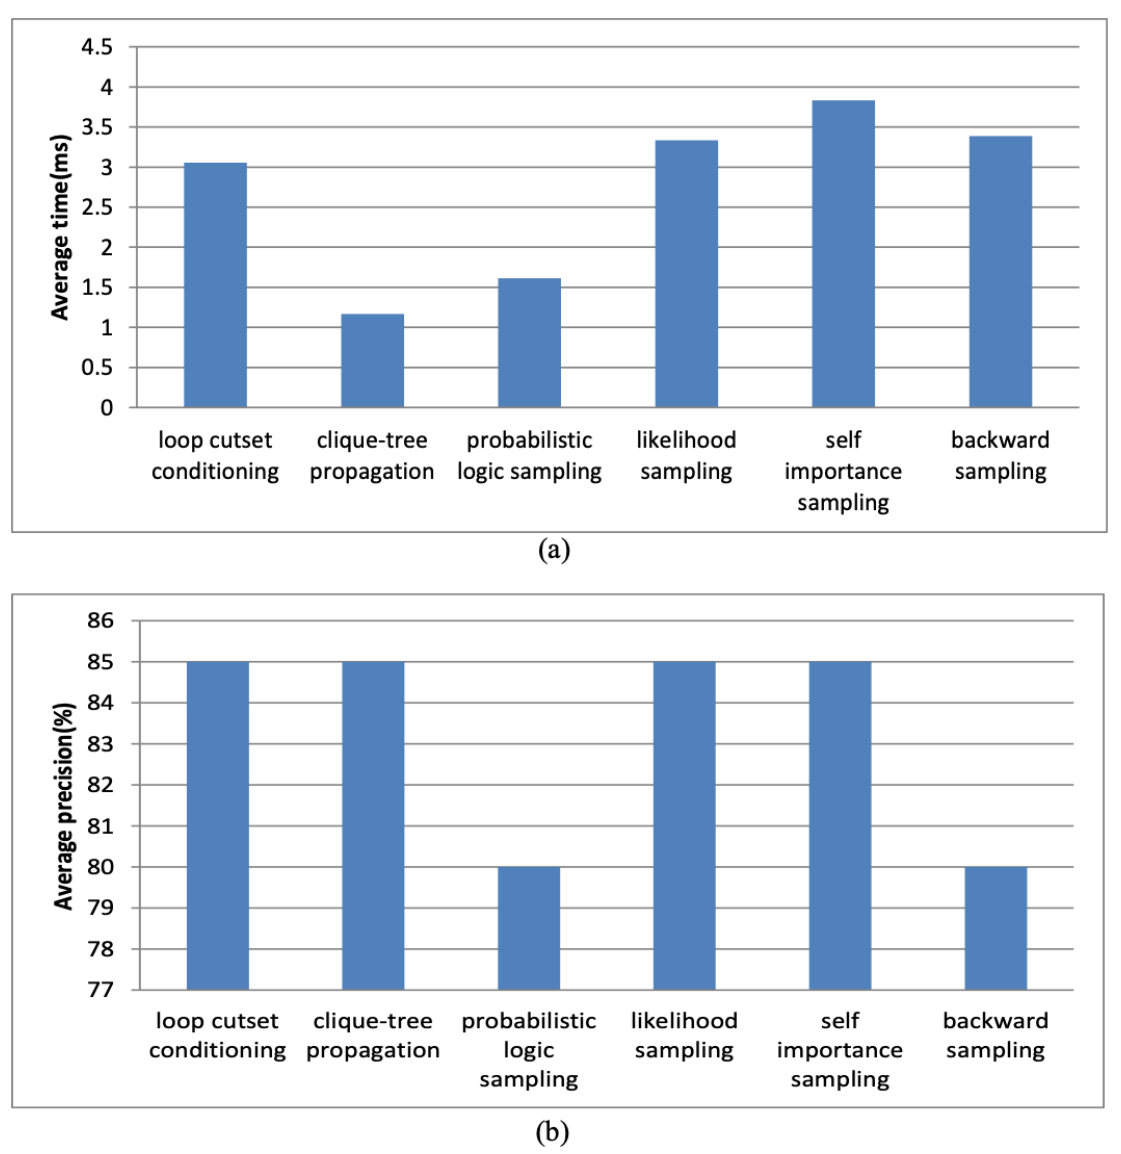
Figure 9. Comparison of six inference algorithms with respect to ( a ) execution time, and ( b )